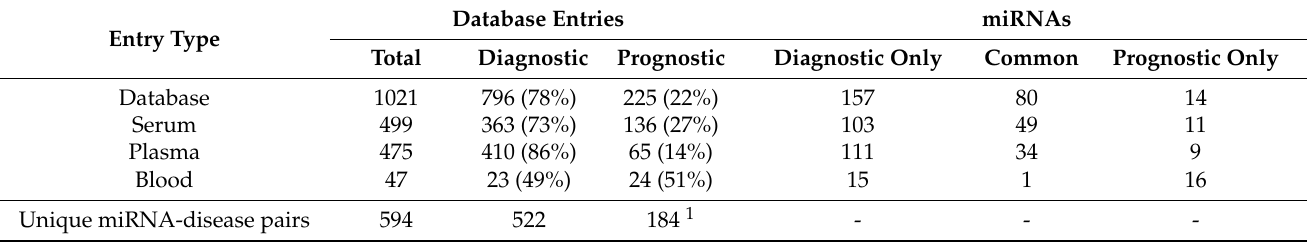
Table 1. Content metrics for plasmiR . Database entry numbers are provided per sample type (Serum/Plasma/Blood) and for the whole database. Sums of entries are further broken down into diagnostic, prognostic, and total (i.e., diagnostic plus prognostic) categories. The sum of unique miRNA-disease pairs is also provided. Numbers of miRNAs that participate in diagnostic, prognostic, or common (i.e., diagnostic and prognostic) pairs are also presented for the whole database and per sample